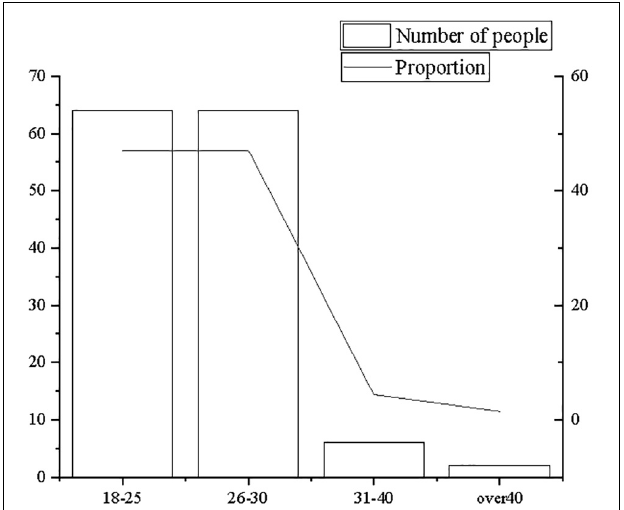
FIGURE 2 | Statistics of age distribution.